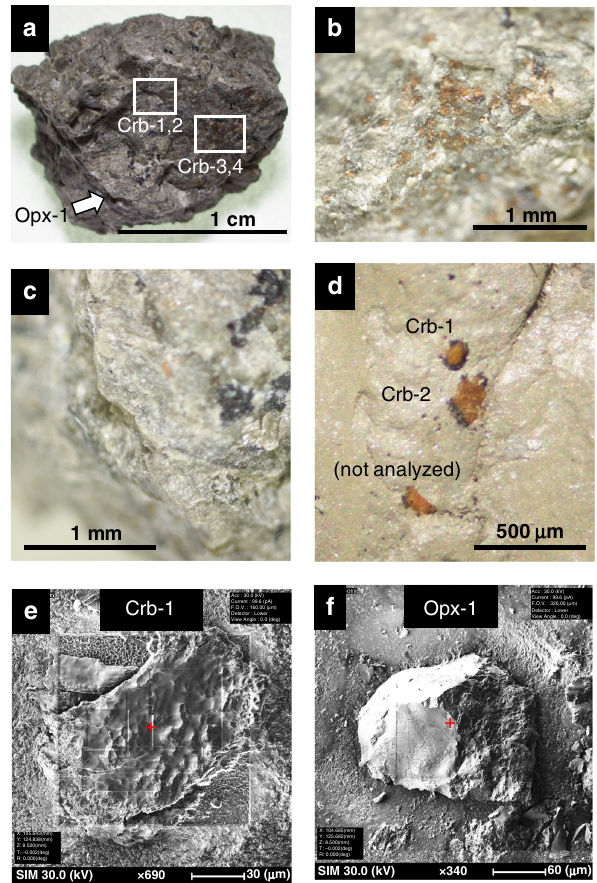
Fig. 1 Optical and secondary electron images of ALH carbonates. a Rock fragment of ALH 84001, 248. The whole size is ~1.5 cm. White squares (Crb-1,2 and Crb-3,4) indicate the locations of orange-colored carbonate patches used for our XANES measurements. A silicate grain was collected from the visibly carbonate-free area, shown by a white arrow in this image (Opx-1). Enlarged images of the carbonate patches ( b ) and the carbonate- free silicates ( c ). d The carbonate grains on a silver double-sided sticky tape. Secondary electron images of the ALH carbonate ( e ) and silicate ( f ) grains. These images were taken after the SEM-FIB processing to remove surface contaminants (see “ Methods ”